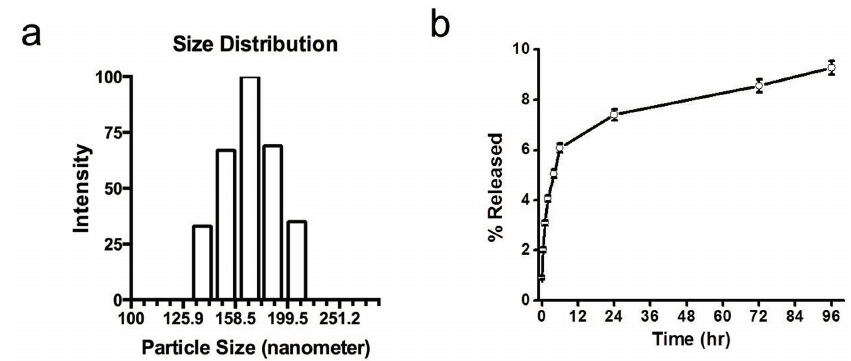
Figure 1. Characterization of near-infrared dye-loaded nanoparticles. ( a ) Gaussian distribution of nanoparticles. Nanoparticles had a mean hydrodynamic diameter of 165 nm with a polydispersity index of 0.135. ( b ) Dye release from nanoparticles in buffer under in vitro conditions. Nanoparticles in release buffer released less than 10% of their total incorporated dye in 96 h. Data show mean ± standard error, with n = 3.